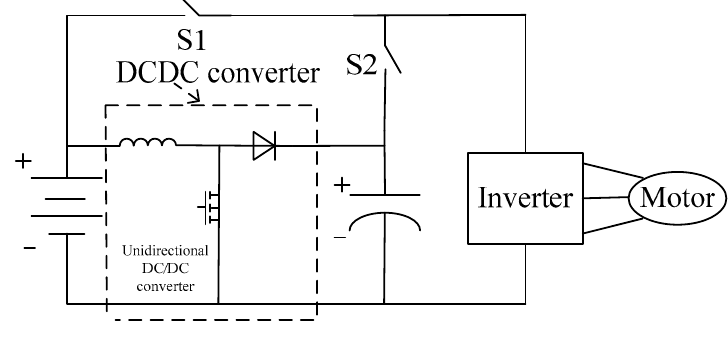
Figure 3. Proposed HESS topology.